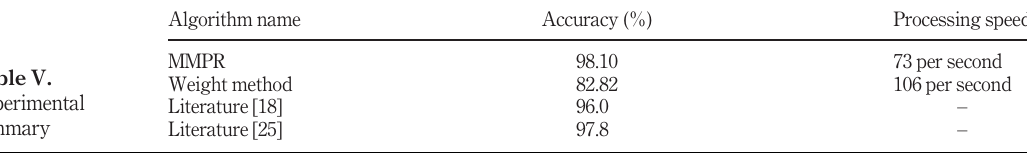
Table IV. Matching results of ten vehicles (low sampling frequency)